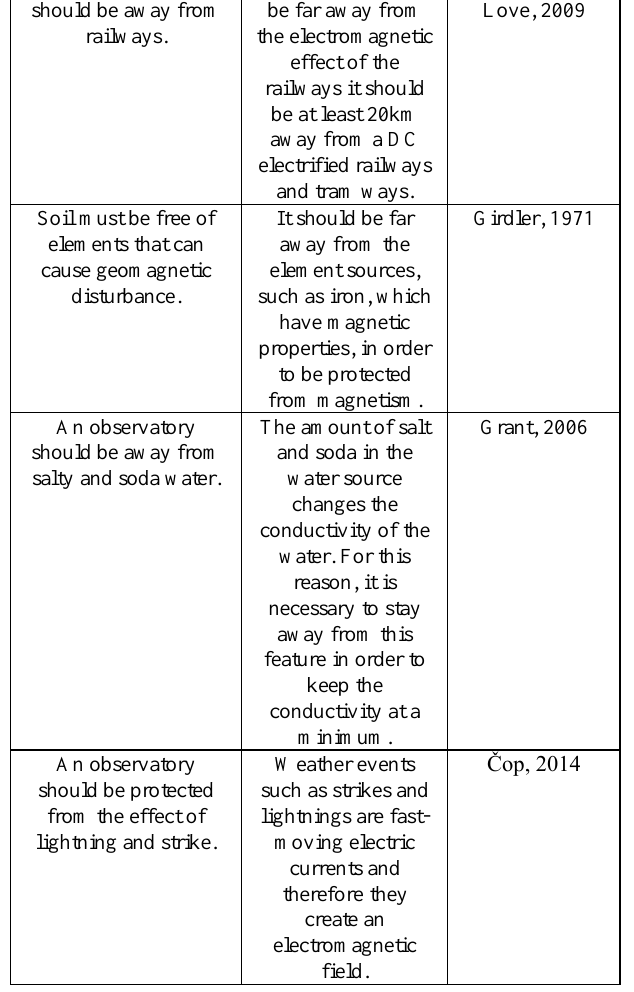
Table 4 . Requirements for a geomagnetic observatory which will be founded with the purpose of space-weather